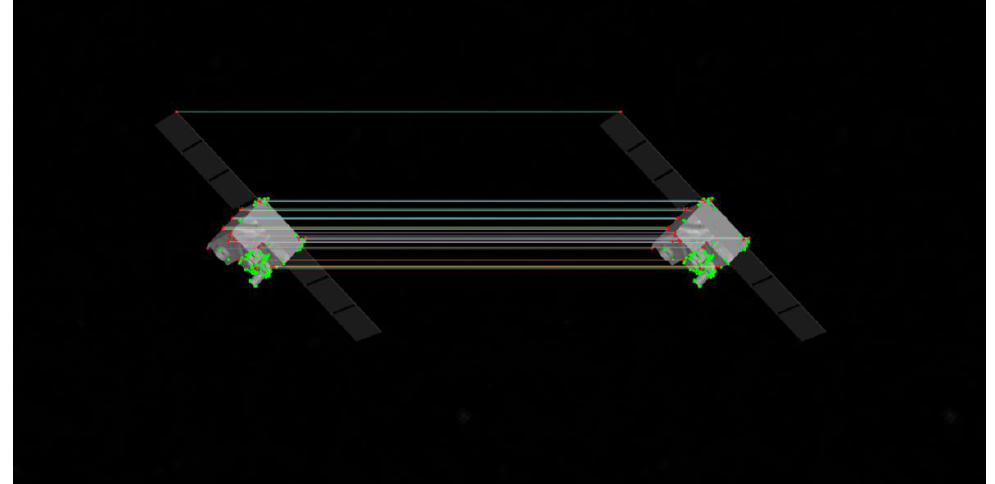
Figure 15. Feature management. The green points are feature points that have been detected in his- tory and can be tracked in this frame. The red points are newly detected feature points and added to the feature point sequence.